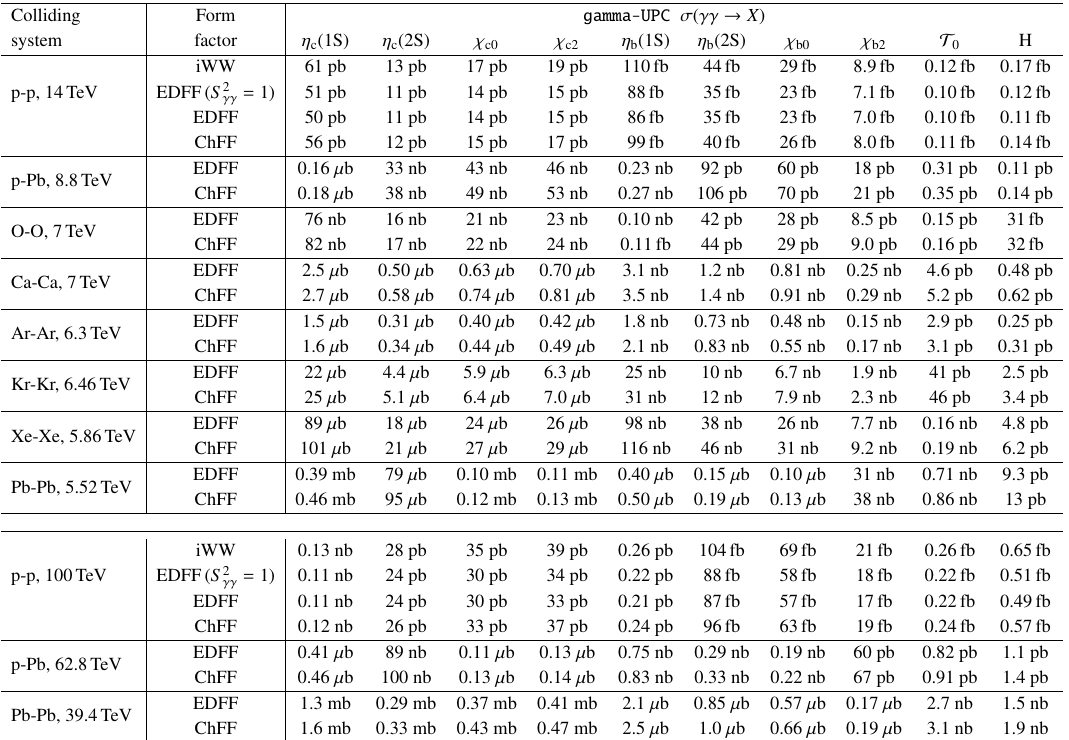
Table 5 . Total photon-fusion cross sections for all known spin-even resonances with masses above m X (cid:25) 3 GeV (table 4) in UPCs for various colliding systems at LHC and FCC c.m. energies. Results derived with EDFF and ChFF are shown for all systems. Associated uncertainties (not quoted) are discussed in the text. In the p-p case, we list also the iWW results using the MG5_ a MC default EPA flux, eq. (1.1), as well as the = 1). EDFF cross sections assuming 100% survival probability ( S 2 (cid:13)(cid:13)